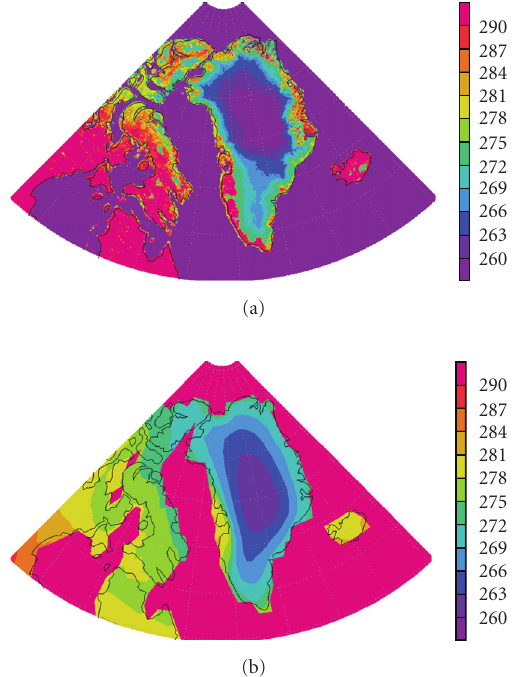
Figure 1: (a) MODIS observed monthly mean land surface skin temperature starting for July, 2003; (b) CCSM/CLM3 simulated 5- year average of July ground surface